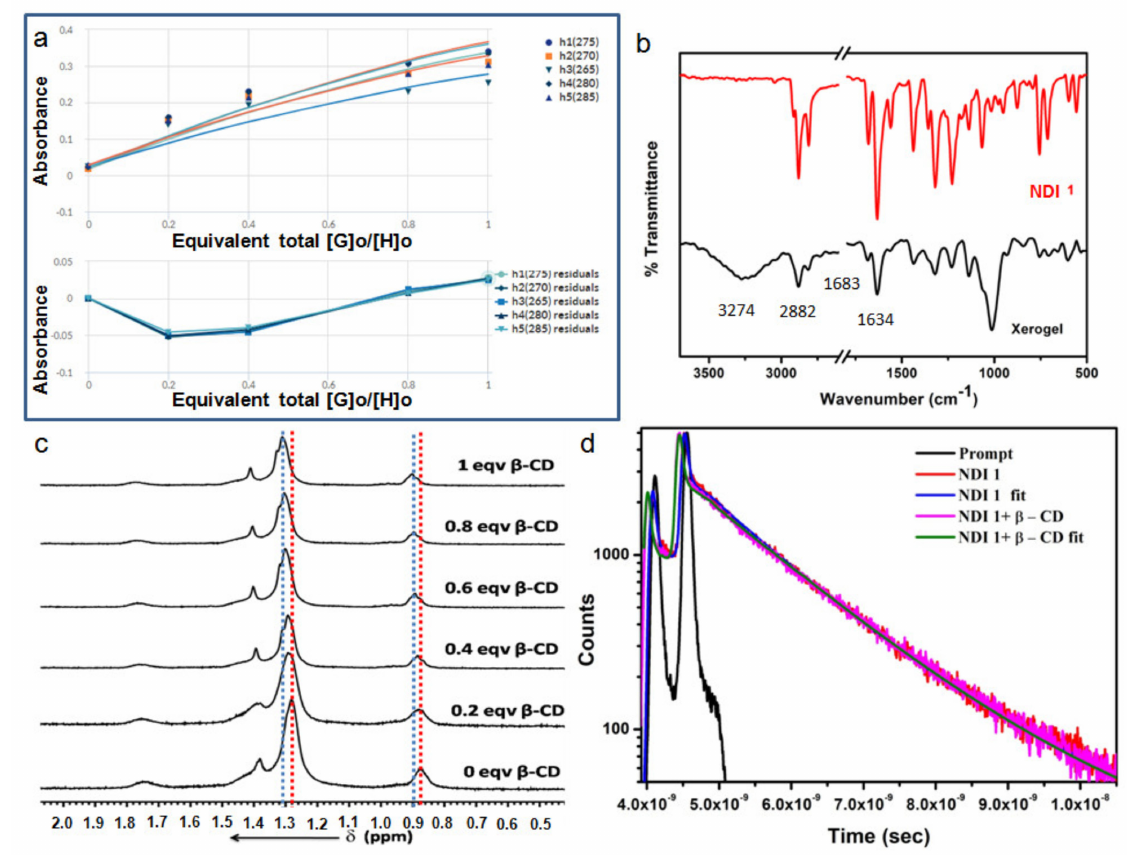
Figure 6. ( a ) The binding stoichiometry of NDI 1 and β -CD in DMF by fitting emission data at 275 nm using the bindfit methods, http://supramolecular.org (accessed on 24 July 2021). ( b ) The FT-IR spectra of only NDI 1 (red) and β -CD- NDI 1 xerogel from DMF; ( c ) Part of 1 H NMR spectra of NDI 1 with the gradual addition of β -CD in DMF- d 7 ; ( d ) Time-resolved fluorescence decay traces of only NDI 1 and NDI 1 - β -CD complex. Excitation wavelength is 375 nm and the emission wavelength is 428